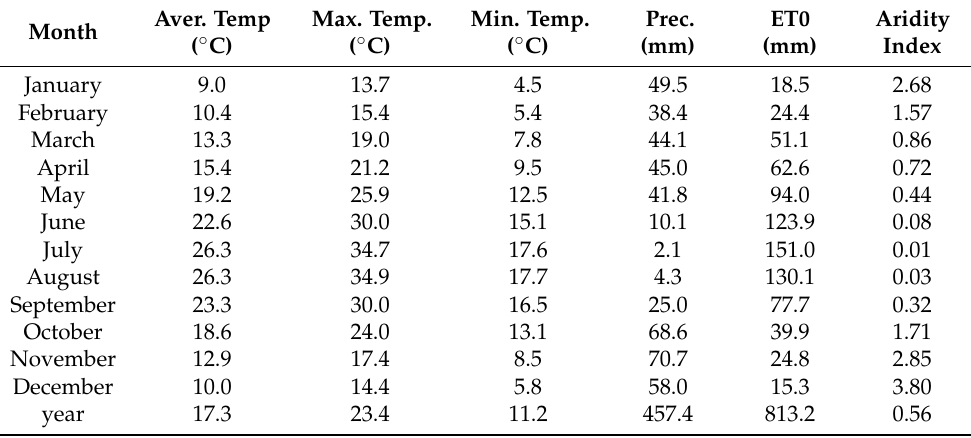
Table 3. Climate normal 1991/2020 (data registered in the study area meteorological